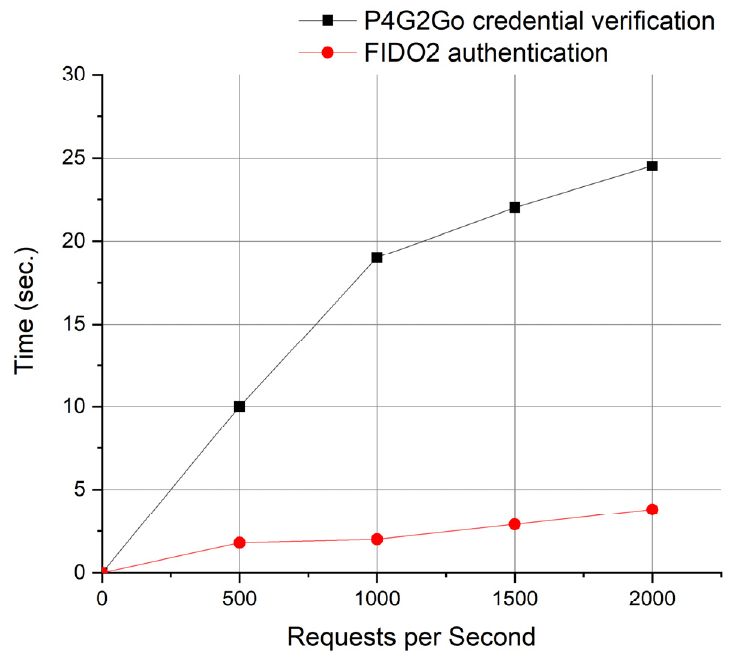
Figure 5. Average Response Time of P4G2Go credential verification vs. FIDO2 authentication.